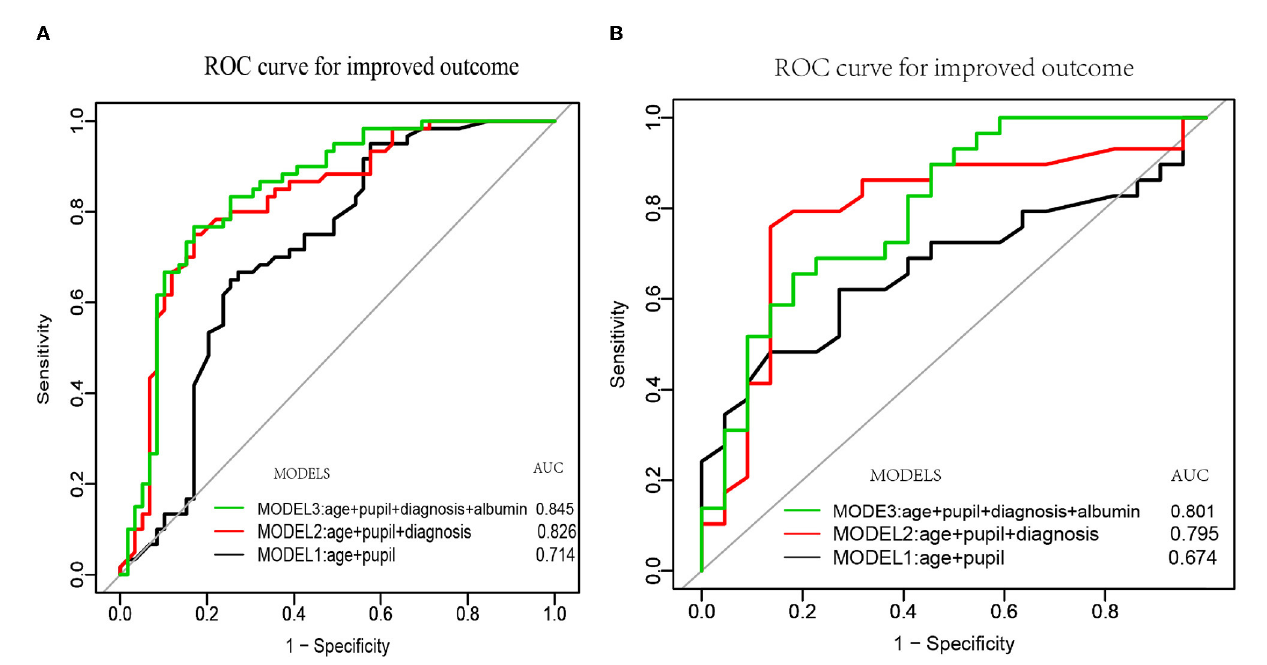
FIGURE5 The ROC curves of age, pupil, diagnosis, albumin, and their combined models. MODEL 1 was constructed based on age and pupil reflex (black curve). MODEL 2 was established based on age, pupil reflex, and diagnosis (red curve). MODEL 3 was established based on age, pupil reflex, diagnosis, and serum albumin (green curve). (A, B) Depict the three ROC curves of the training and validation cohorts,